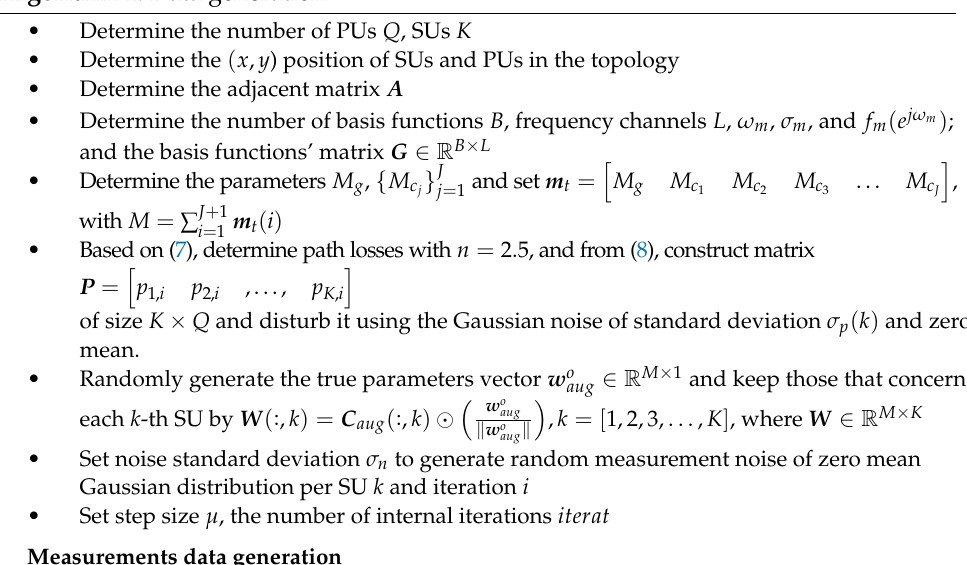
Algorithm 1: Data